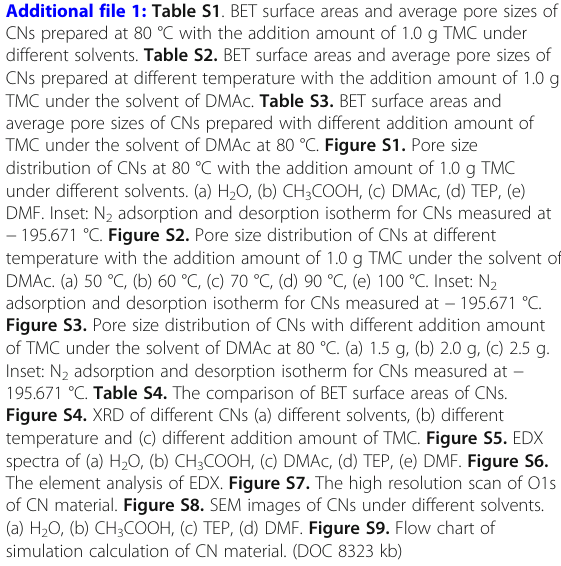
Figure S3. Pore size distribution of CNs with different addition amount of TMC under the solvent of DMAc at 80 °C. (a) 1.5 g, (b) 2.0 g, (c) 2.5 g. Inset: N 2 adsorption and desorption isotherm for CNs measured at − 195.671 °C. Table S4. The comparison of BET surface areas of CNs. Figure S4. XRD of different CNs (a) different solvents, (b) different temperature and (c) different addition amount of TMC. Figure S5. EDX spectra of (a) H 2 O, (b) CH 3 COOH, (c) DMAc, (d) TEP, (e) DMF. Figure S6. The element analysis of EDX. Figure S7. The high resolution scan of O1s of CN material. Figure S8. SEM images of CNs under different solvents. (a) H 2 O, (b) CH 3 COOH, (c) TEP, (d) DMF. Figure S9. Flow chart